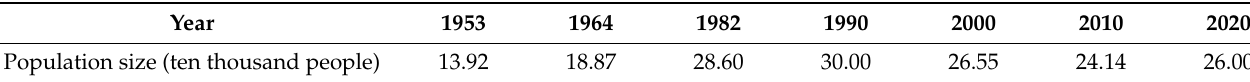
Table 1. Permanent Changshan County population.